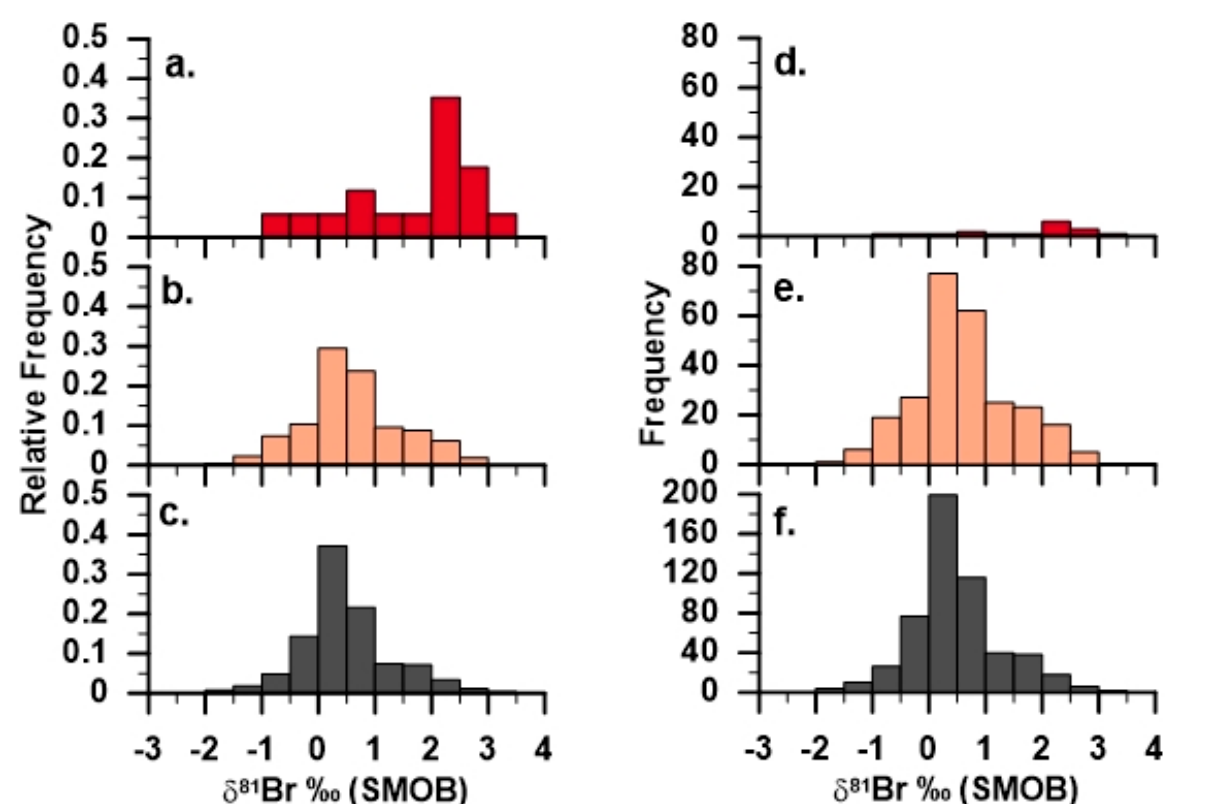
Figure 6. Relative frequency ( a – c ) and frequency ( d – f ) of δ 81 Br values in this study ( a , d ), sedimentary basins ( b , e ), and all known groundwater samples analyzed to date ( c , f ) [10–22,70–73]. Note the change in scale in panel ( f ) compared with ( d ) and ( e ).